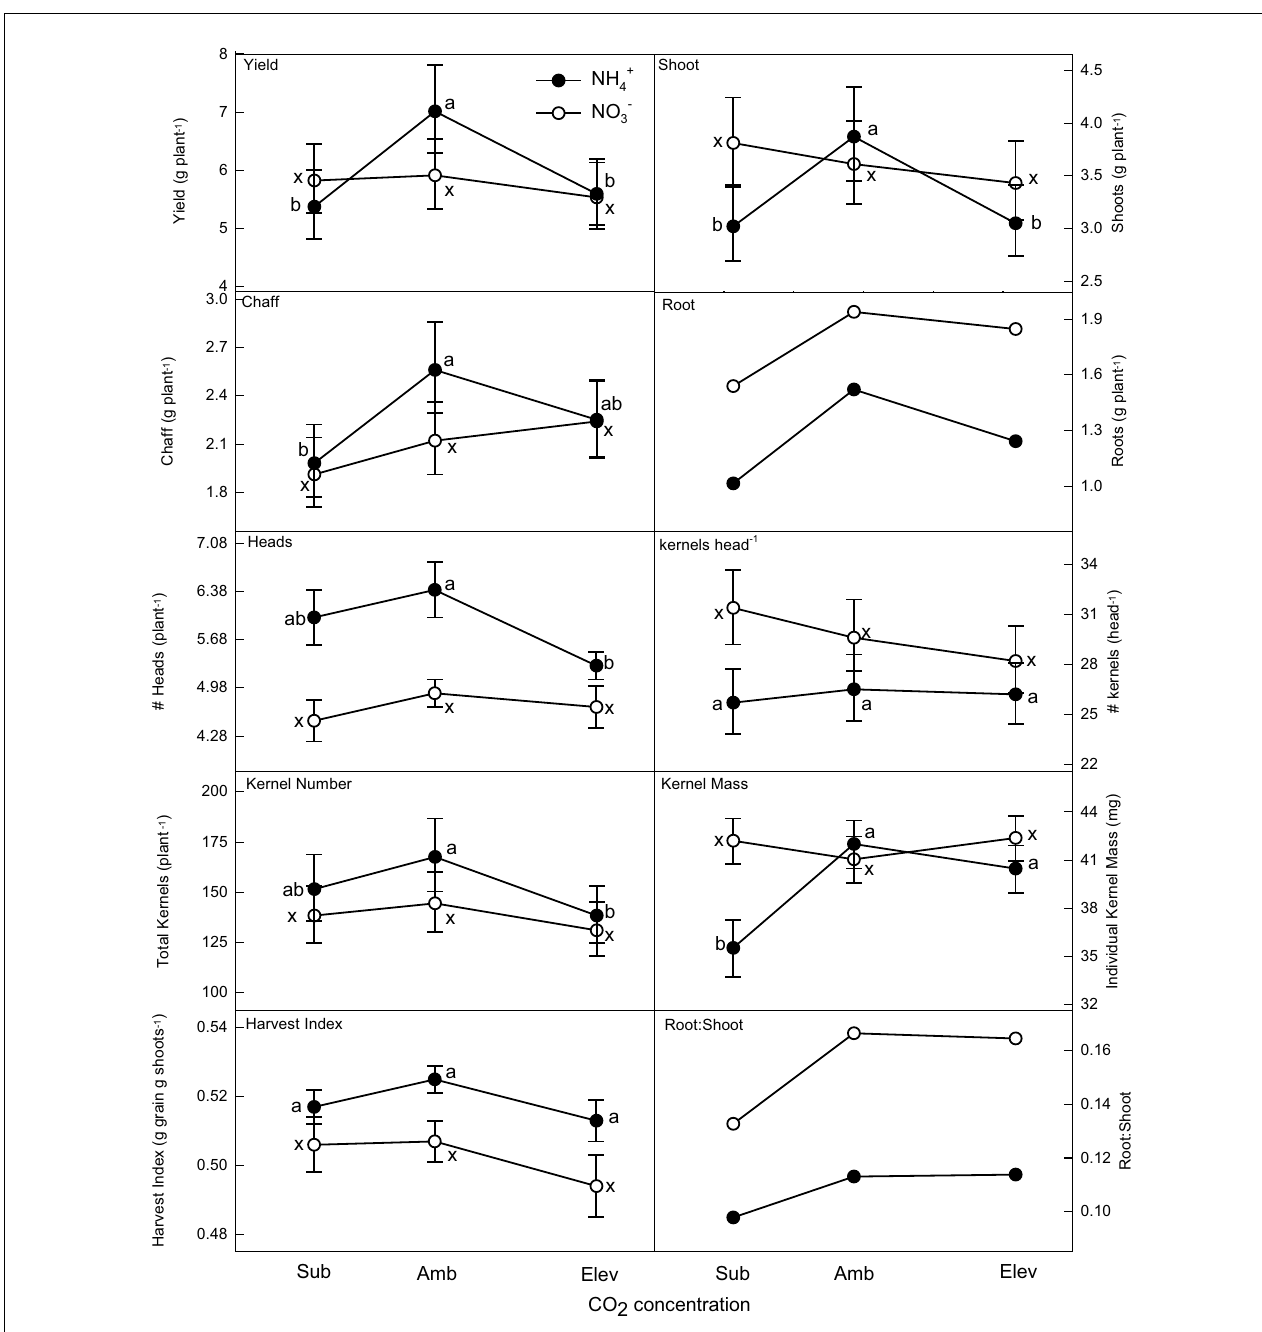
FIGURE 1 |The effect of N form and CO 2 concentration on biomass and yield components of wheat hydroponically grown to senescence. Closed ) and open (NO − ) symbols and error bars represent the (NH + 4 3